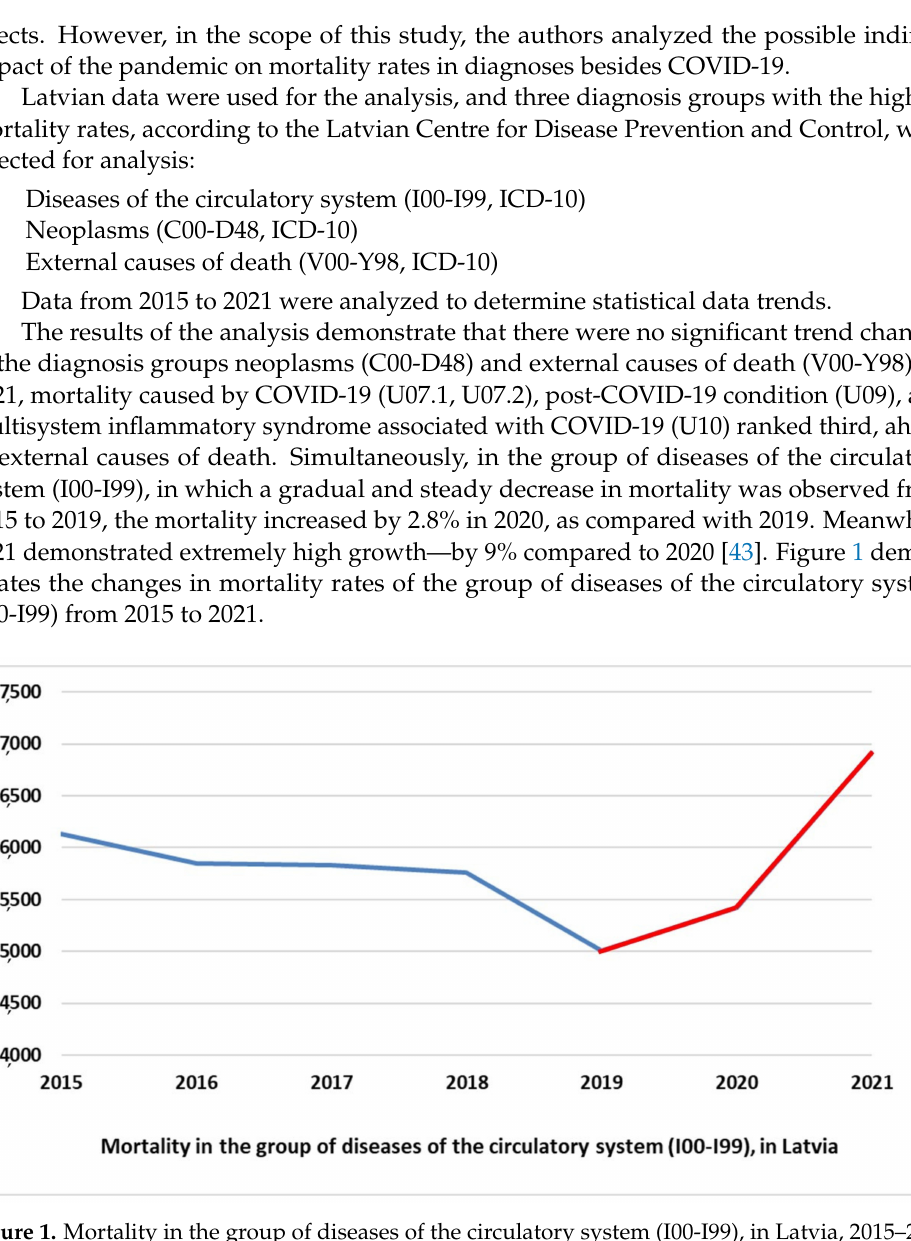
Figure 1. Mortality in the group of diseases of the circulatory system (I00-I99), in Latvia, 2015–2021 (constructed by the authors, using the publicly available statistical data of the Latvian Centre for Disease Prevention and Control (CDPC)